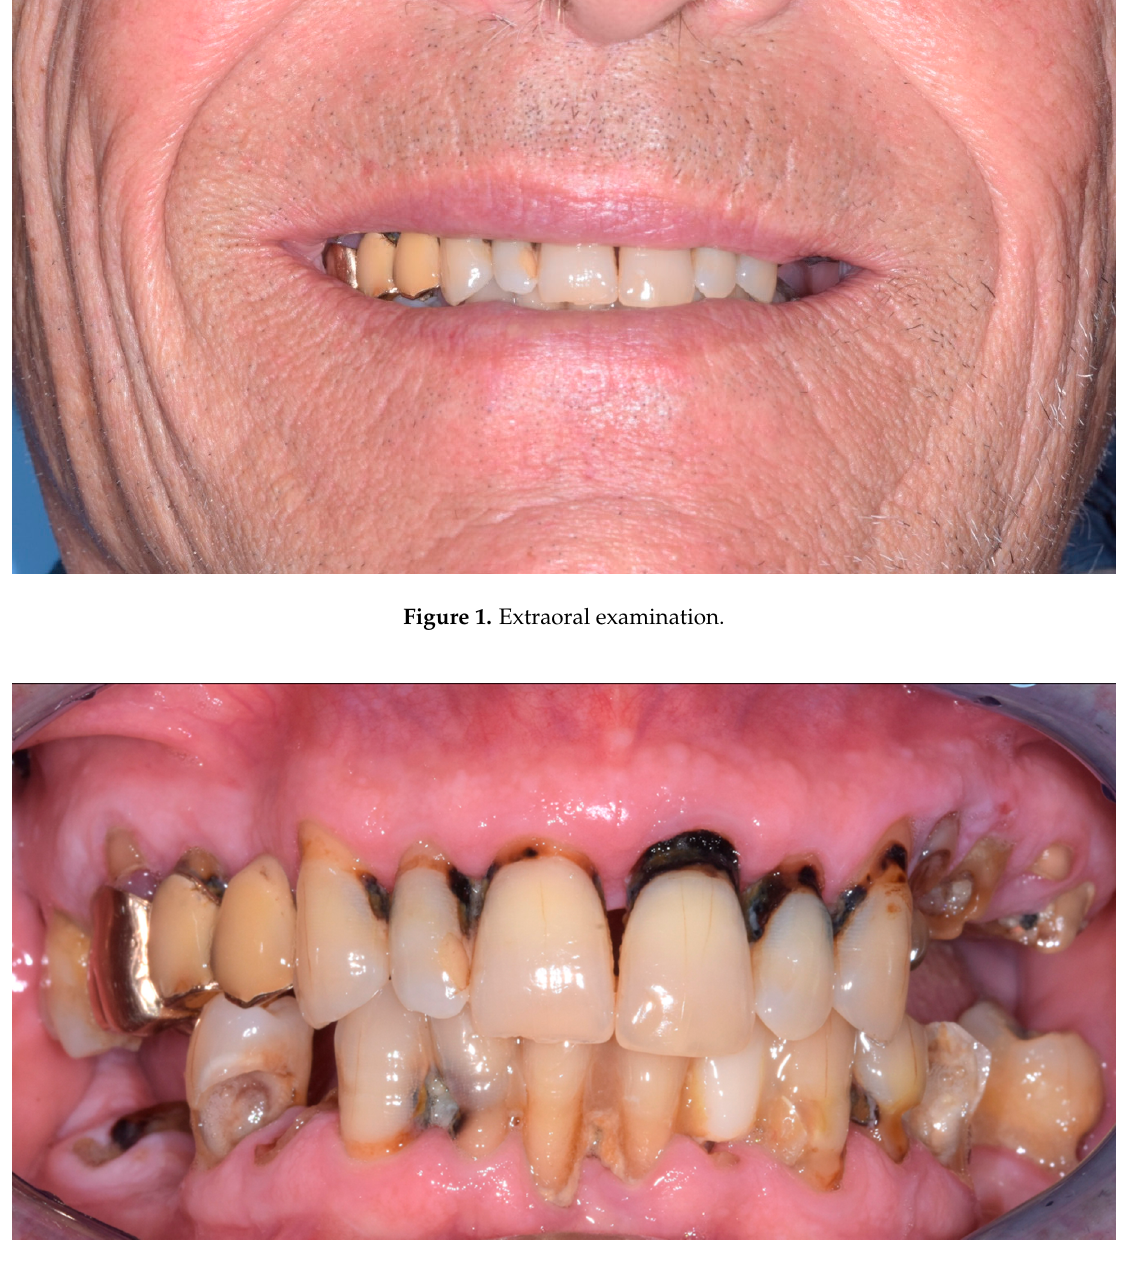
Figure 2. Intraoral frontal view of the patient’s dentition in occlusion.